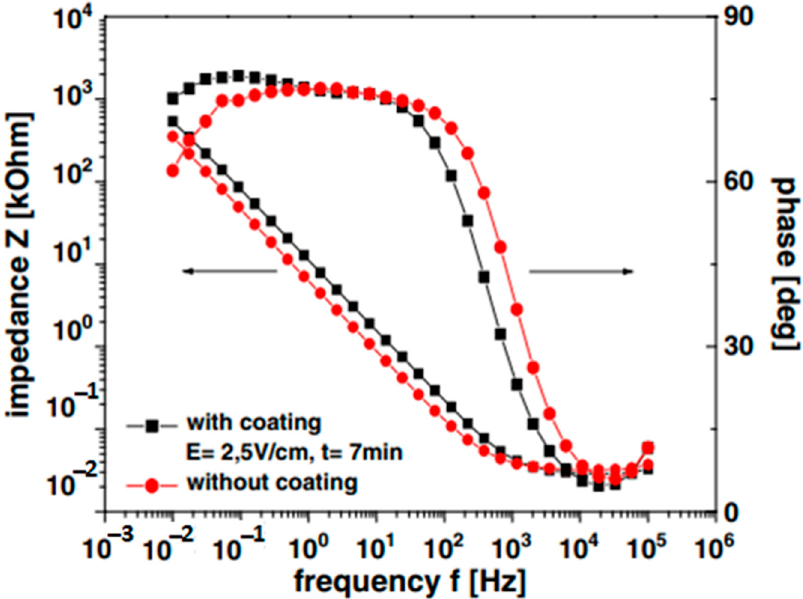
Figure 10. Impedance spectra of chi coated (at 2 and 5 V/cm) and uncoated SS in SBF at 37 °C. Reproduced from [80] with permission from Elsevier™.